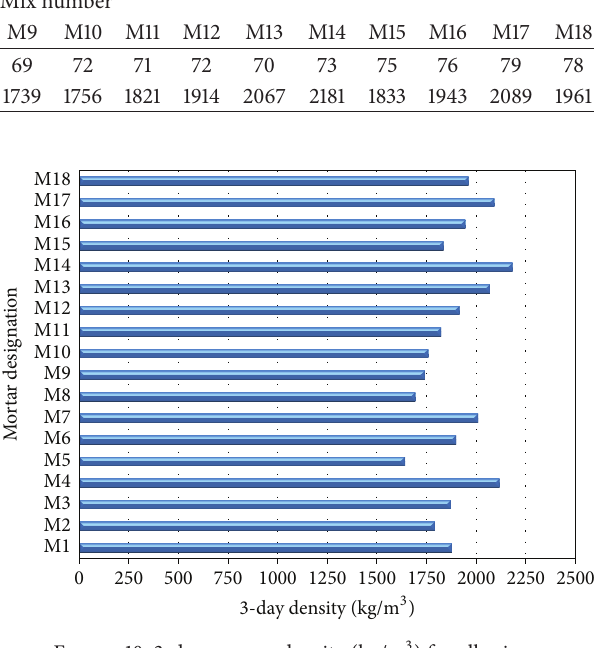
Figure 10: 3-day average density (kg/m 3 ) for all mixes.